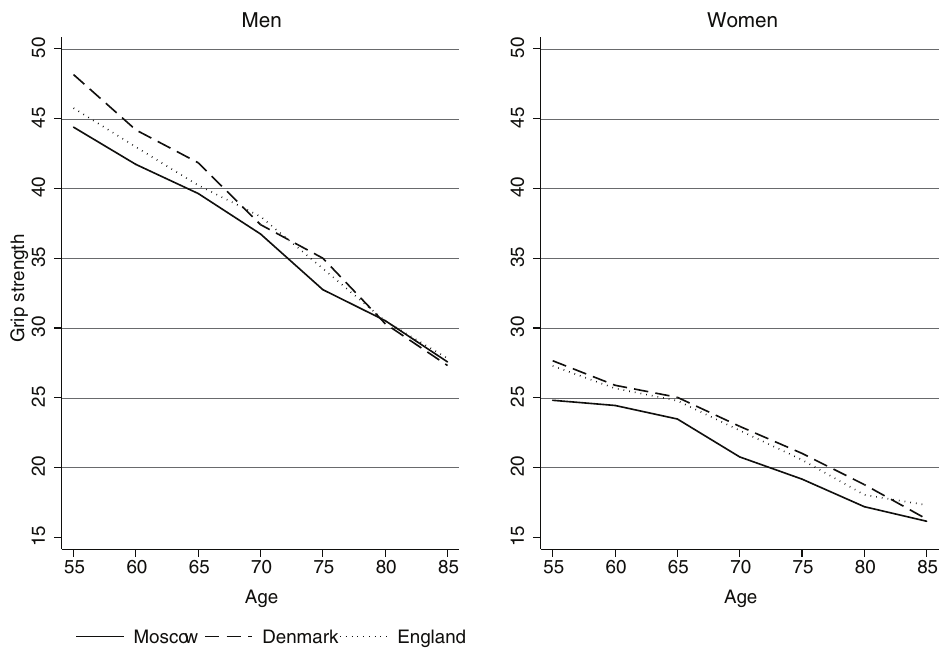
Fig 1. Cross-sectional age trajectories of grip strength in Moscow, Denmark, and England.